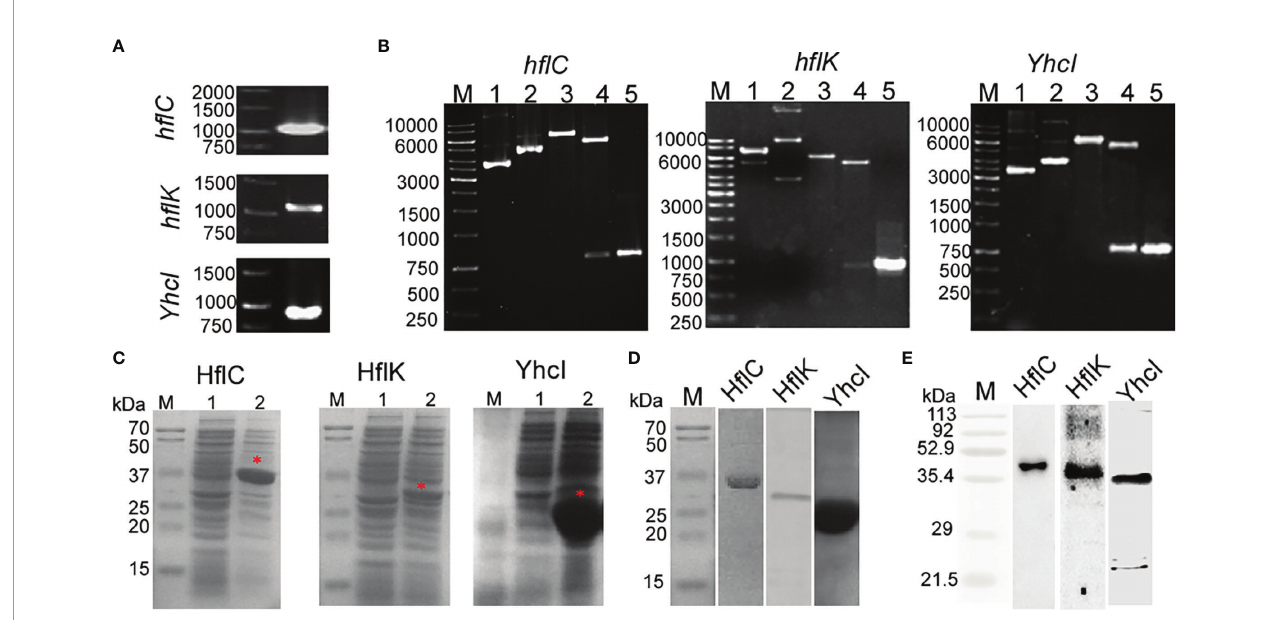
FIGURE 3 | (A) PCR ampli fi ed product of h fl C (a), h fl K (b), and YhcI (c) from the genomic DNA of strain E. tarda ED-BDU1, (B) Restriction analysis and colony PCR analysis of h fl C (a), h fl K (b), and YhcI (c) from the E. coli BL21 transformants. (M- 1kb marker, 1- Vector pET28a, 2- construct pET28a+ampli fi ed gene, 3- single digestion of construct pET 28a+ ampli fi ed gene using EcoRI for h fl C and h fl K genes, BamHI for YhcI gene, 4-Double digestion of construct pET28a+ ampli fi ed gene using EcoRI and HindIII for h fl C and h fl K, BamHI genes and XhoI for YhcI gene and 5- Colony PCR product of the respective gene). (C) Expression of the h fl C (a), h fl K (b), and YhcI (c) proteins as con fi rmed by SDS-PAGE pro fi ling. (Lane M: Marker, Lane 1: Uninduced whole cell lysate, Lane 2: IPTG induced whole cell lysate). (D) SDS- PAGE pro fi ling of puri fi ed recombinant proteins (H fl C, H fl K, and YhcI). (E) Immunoblot analysis of puri fi ed recombinant proteins (H fl C, H fl K, and YhcI) probed with speci fi c rabbit polyclonal antiserum.